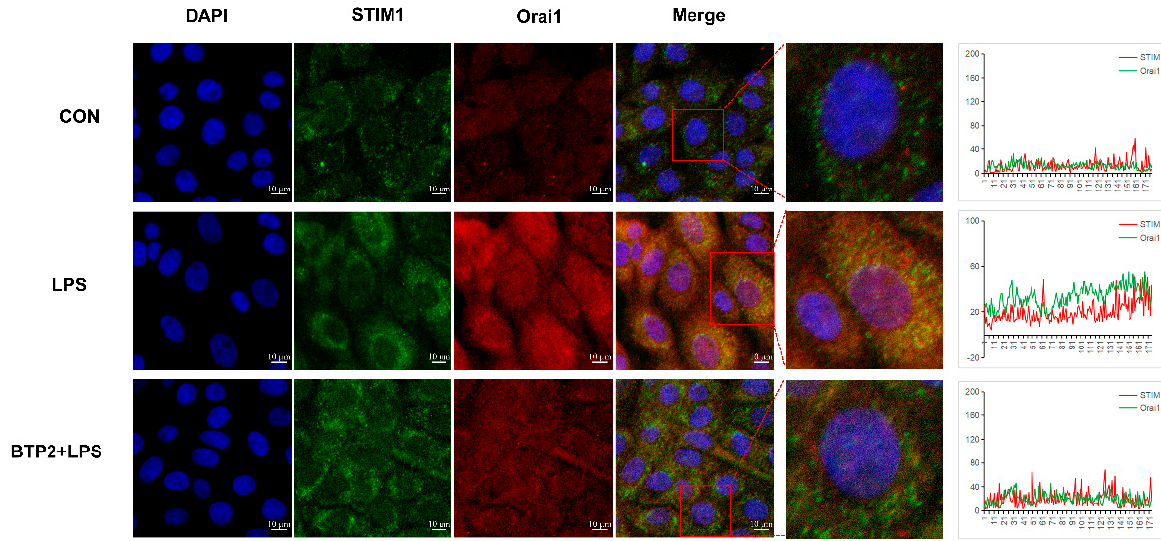
Figure 7. Protein expression and location of STIM1/Orai1 in BMEC. DAPI blue fluorescence was used to label the nuclear location, FITC green fluorescence was used to label STIM1 protein, and Cy3 red fluorescence was used to label Orai1 protein. ImageJ was used to draw the line graph to show the fluorescence co-location trends.